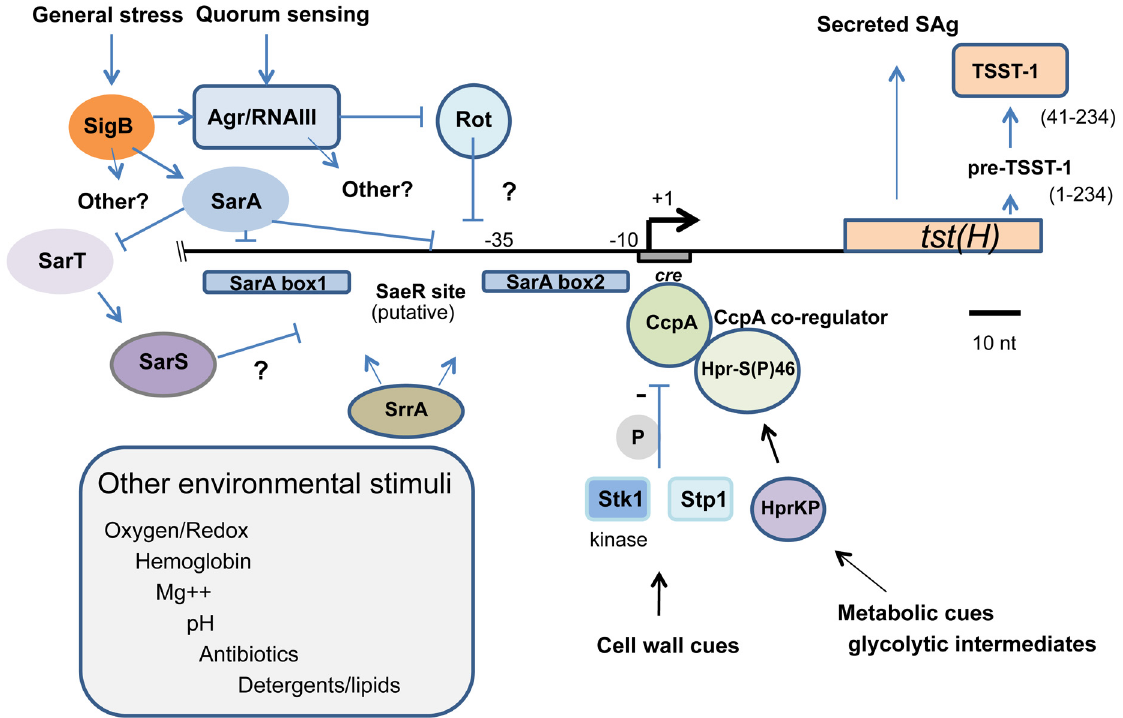
Fig 6. Model depicting the regulation of the TSST-1 superantigen in S . aureus . The horizontal line shows the position of the transcriptional start site (+1) determined in RN4282 and 37 nucleotides upstream of the translation start site [40]. The positions of SarA boxes 1 and 2 are shown and correspond to their positions determined by both SarA consensus and direct DNA binding assay [40]. Negative regulators determined in the study reported herein include σ B , SarA, and Rot. SarA modulation of SarS is thought to occur via SarA negative regulation of the SarS activator SarT [65]. Catabolite control protein a (CcpA) binding to its cognate cis- acting cre site mediates additional tst repression by integrating signals from glycolytic intermediates via phosphorylation of the CcpA co-regulator as well as direct phosphorylation ( grey P ) via the Stk1 kinase which affects its DNA binding affinity [25, 44, 69]. The Stk1 S/T kinase and its cognate phosphatase, Stp1, may impart additional levels of control via the phosphorylation of SarA and the nucleoid protein, Hu, for example [45, 70, 71]. SrrA, the response regulator of the SrrAB two-component sensor, is thought to control tst regulation in response to oxygen and coenzyme Q [29, 30, 69, 100]. SrrA specific binding has been detected in the tst promoter region (Andrey, manuscript in preparation). DNA sequence with strong similarity to the consensus DNA binding site for the response regulator SaeR is shown. Although the precise involvement of SaeRS in tst regulation is unknown, it may help coordinate response to pH together with sigB [34, 101, 102]. Additional environmental stimuli known to affect TSST-1 expression are boxed although the precise genetic factors mediating these effects have yet to be defined [32, 102 – 107].